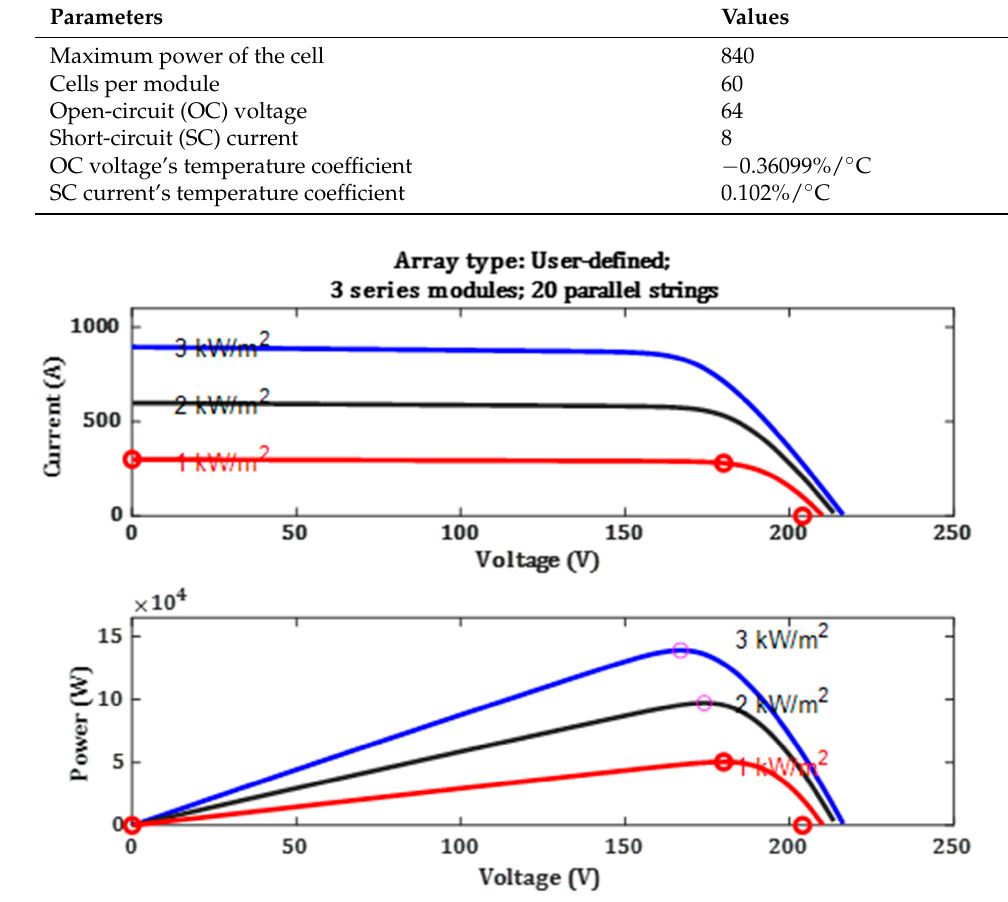
Table 2. Solar-array specifications [10].